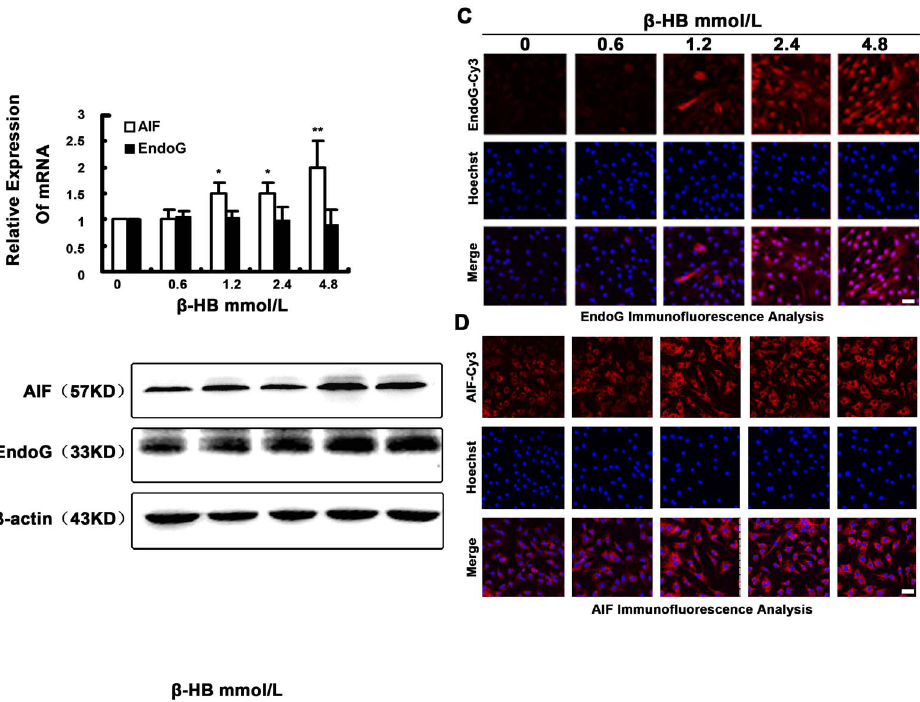
Figure 6. Effect of b -HB on AIF and EndoG expression and translocation in BSMCs. Cells were incubated 48 h with b -HB (0, 0.6, 1.2, 2.4 or 4.8 mM) in serum-free medium. A) AIF and EndoG mRNA were detected by Q-PCR, and the ratios of AIF and EndoG to b -actin were calculated. B) AIF and EndoG protein were detected by Western blot. C) and D) Protein localization of AIF and EndoG was detected by immunofluorescence. The mean of three independent experiments is shown. *p , 0.05, **p , 0.01 versus control group.